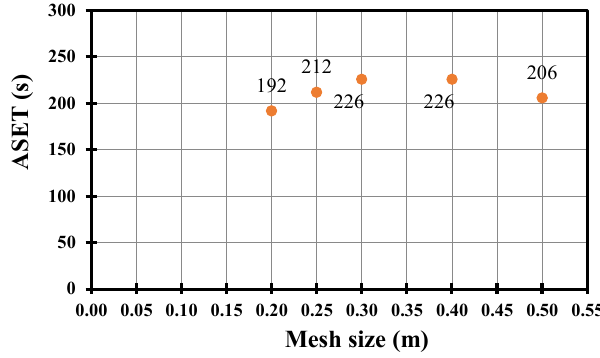
Figure A2. ASET according to the mesh size.